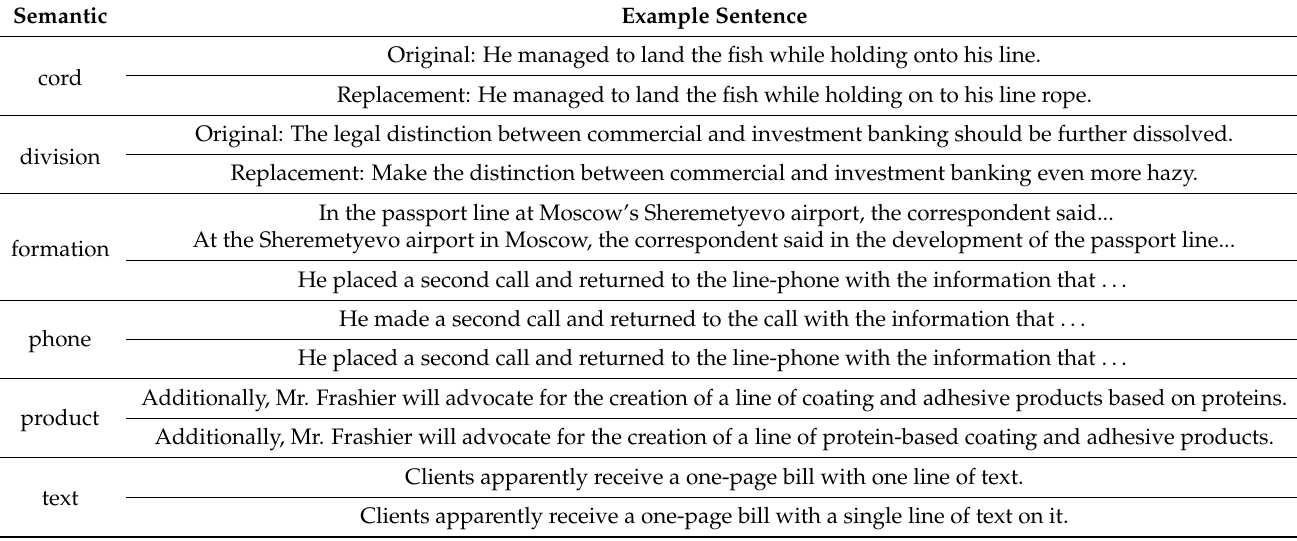
Table 1. Training corpus of polysemous word vectors (with polysemous word leash as an example). Semantic Example